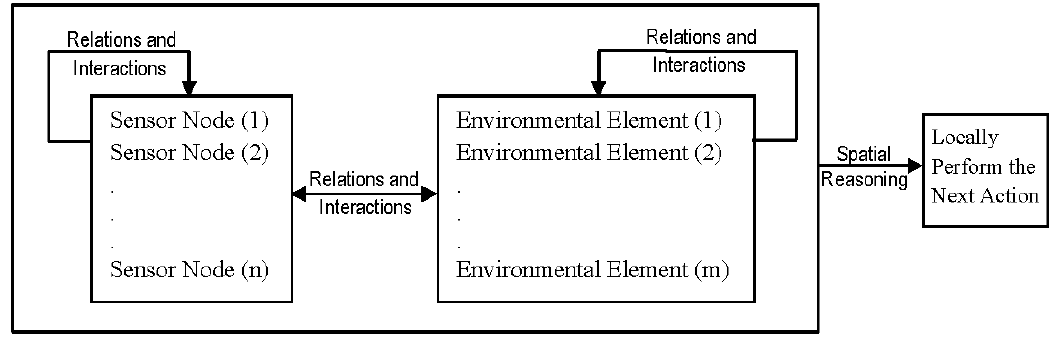
Figure 2. Context definition for the intelligent sensor deployment for a given